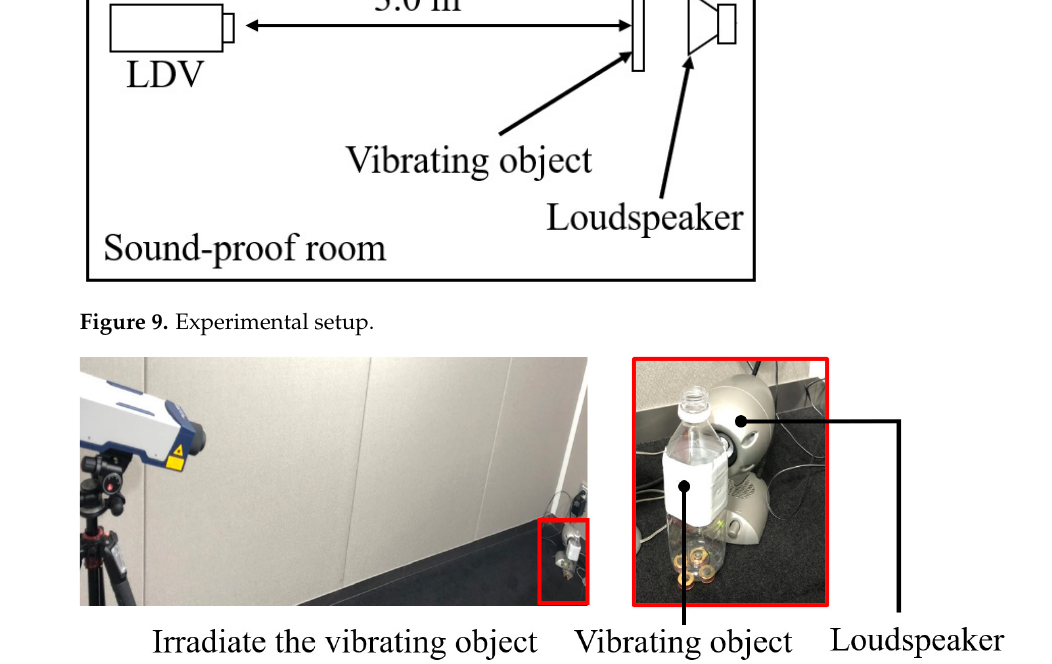
Figure 10. Experimental recording